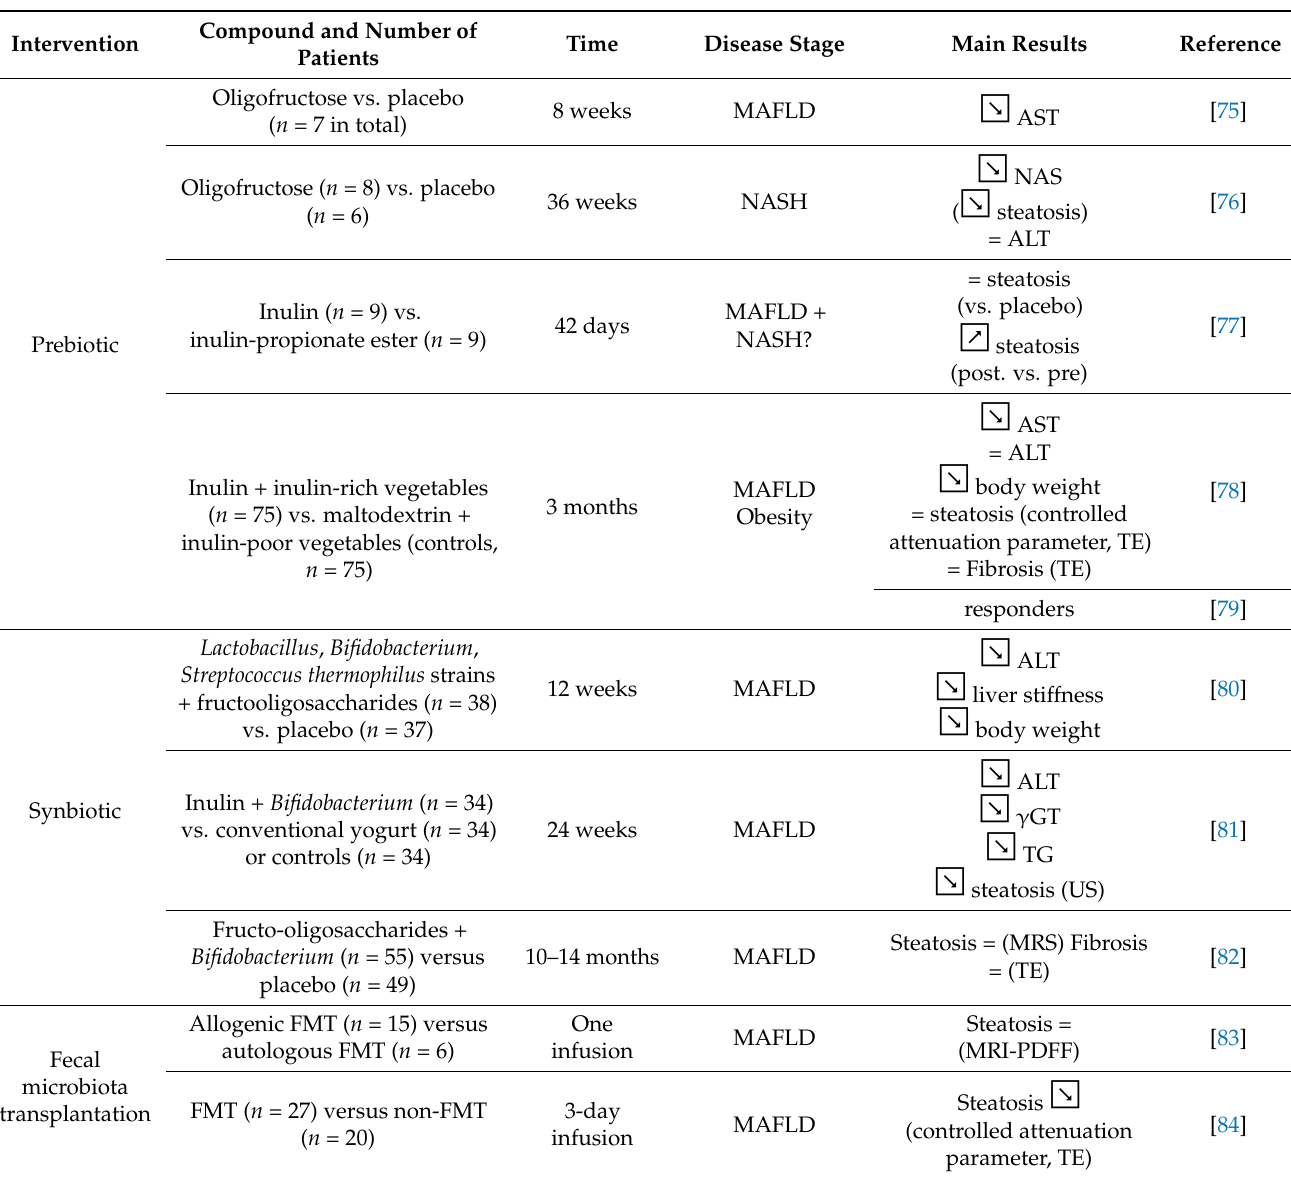
Table 3. Clinical trials with antibiotics, probiotics, prebiotics, synbiotics or fecal microbiota trans- plantation in metabolic dysfunction-associated fatty liver disease (MAFLD) or non-alcoholic steato- hepatitis (NASH).